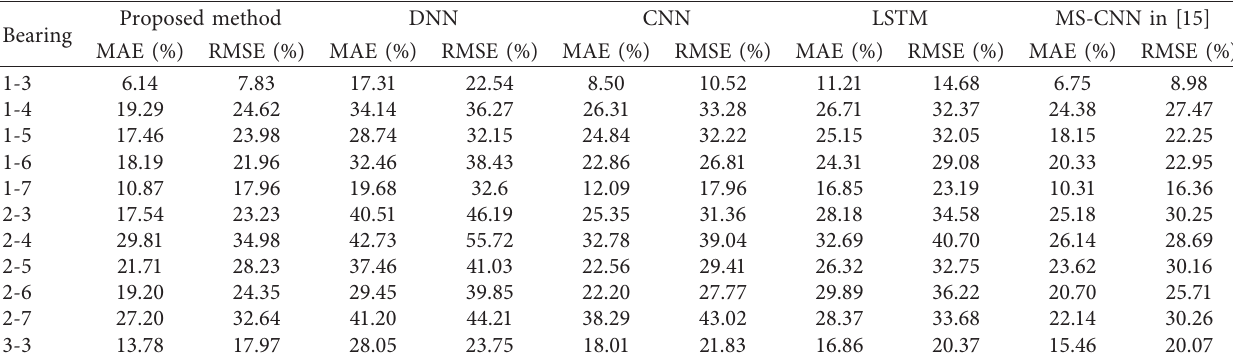
Table 3: Performance comparisons with different methods. Proposed Bearing